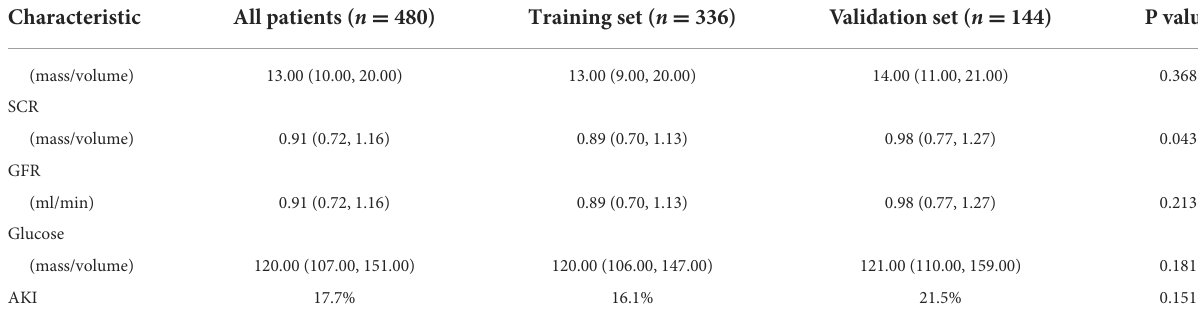
overall population, 16.1% (54 of 336) in the training set, and 21.5% (31 of 144) in the validation set, respectively (Table